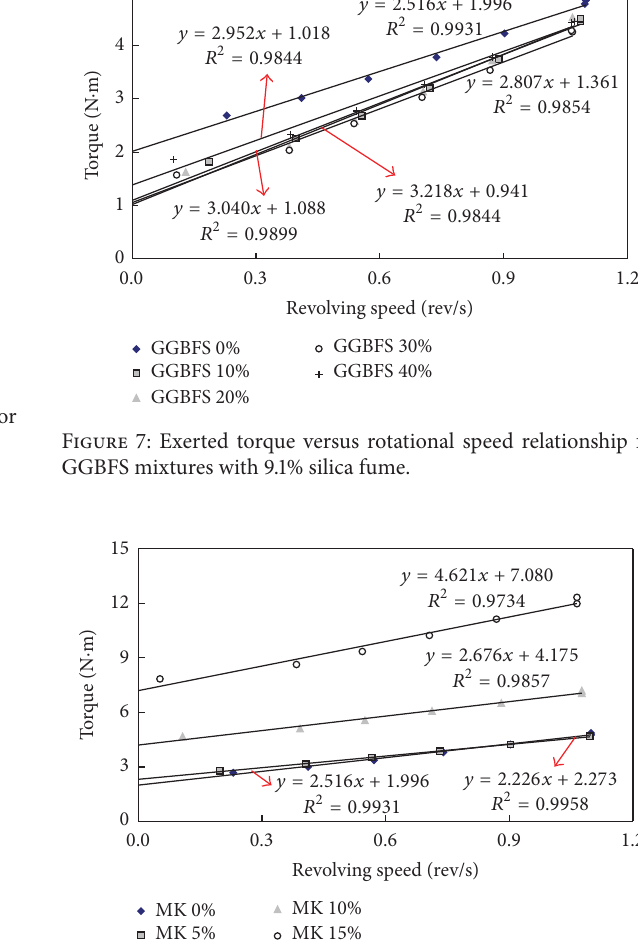
Figure 6: Exerted torque versus rotational speed relationship for fly ash mixtures with 9.1% silica fume.